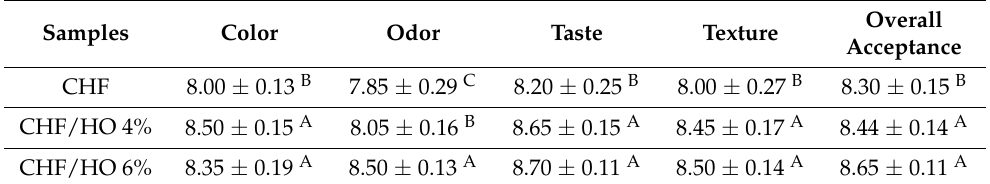
Table 4. Acceptability of grilled un-inoculated chicken fillet fortified with lyophilized HO algal extract depending on sensory